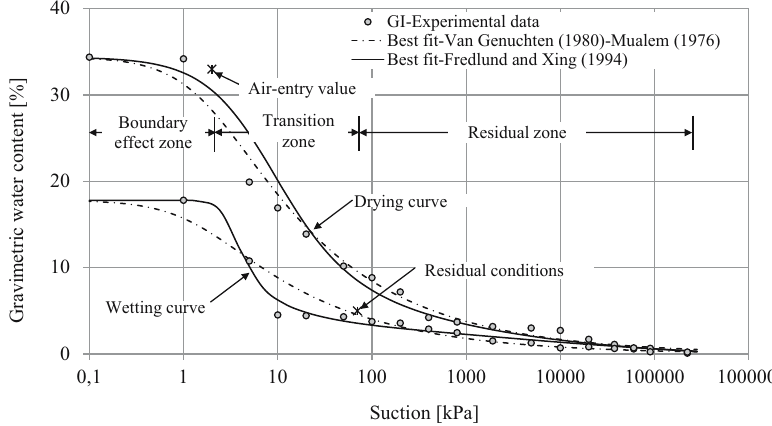
Figure 4: Soil – water characteristic curve, gravimetric water content versus suction for GI soil.